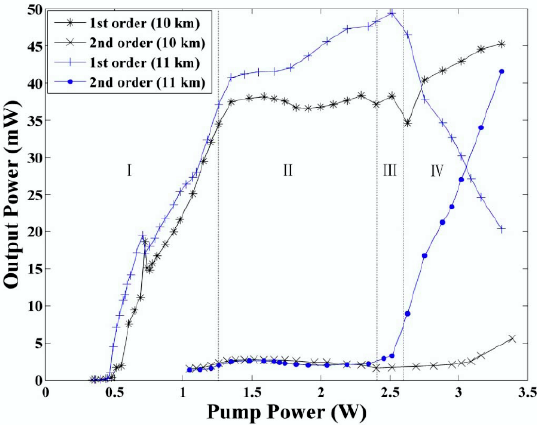
Figure 7. Output power as a function of pump power [88].